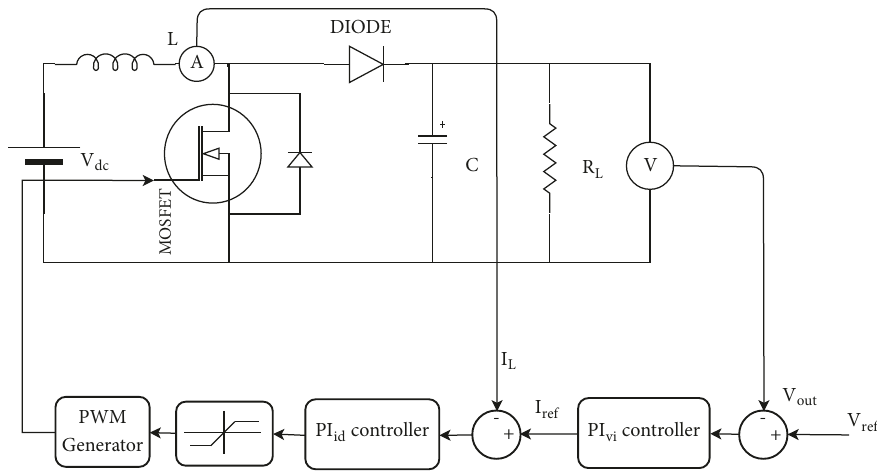
Figure 5: Basic structure of 𝑃𝐼 V 𝑖 and 𝑃𝐼 𝑖𝑑 controllers for the two loops.